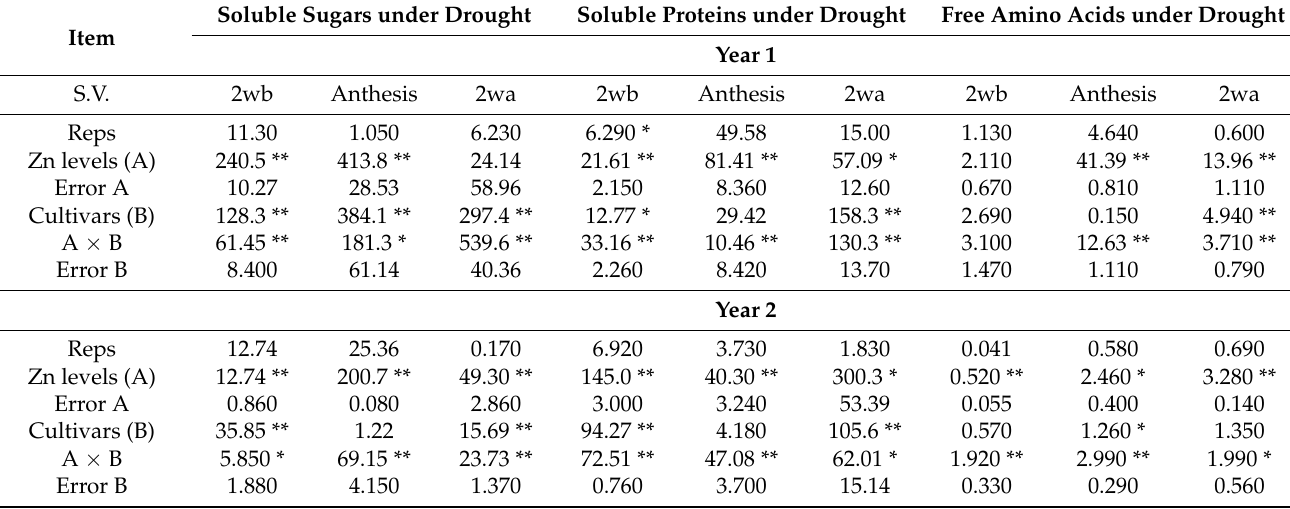
Table 1. Mean squares of separate and combined analyses of the metabolites under drought stress and normal irrigation 2 weeks before anthesis (2wb), at anthesis, and 2 weeks after anthesis